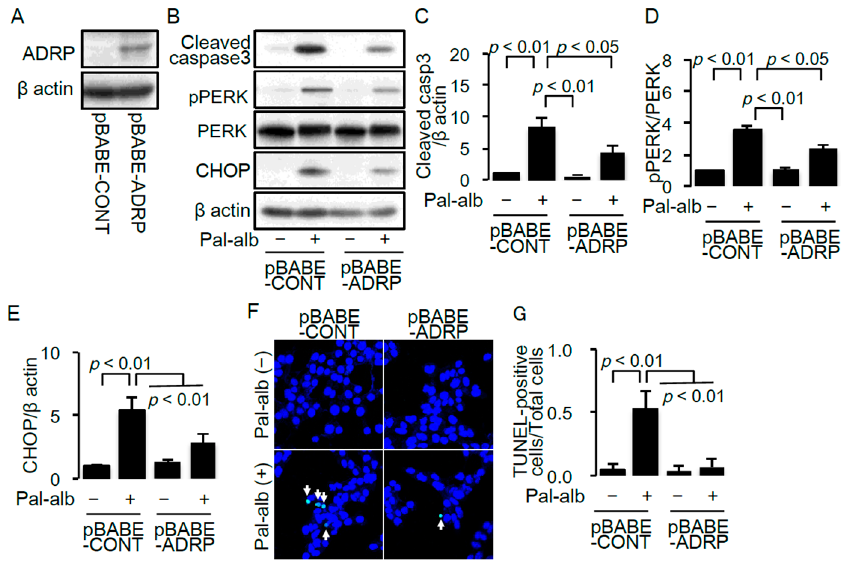
Figure 5. ( A ) Representative immunoblot of ADRP in cultured proximal tubular cells infected with the control retrovirus (pBABE-CONT) or the retrovirus for ADRP overexpression (pBABE-ADRP); ( B ) Representative immunoblot of cleaved caspase 3, pPERK, PERK and CHOP in pBABE-CONT or pBABE-ADRP transfected cells, treated with/without palmitate. β -actin was used as a loading control; Quantitative results of cleaved caspase 3 ( C ), pPERK/PERK ratio ( D ) and CHOP ( E ) ( n = 4); ( F ) Representative pictures of TUNEL staining for detecting apoptotic cells in pBABE-CONT or pBABE-ADRP transfected cells, treated with/without palmitate. White arrows indicate TUNEL-positive apoptotic cells; ( G ) Quantitative results of TUNEL staining. Data are shown as mean ± SD. p < 0.05 indicates statistical significance. ADRP, adipose differentiation-related protein; pPERK, PKR-like ER kinase (PERK) phosphorylated at Thr980; CHOP, C/EBP homologous protein; SCD, stearoyl-CoA desaturase.